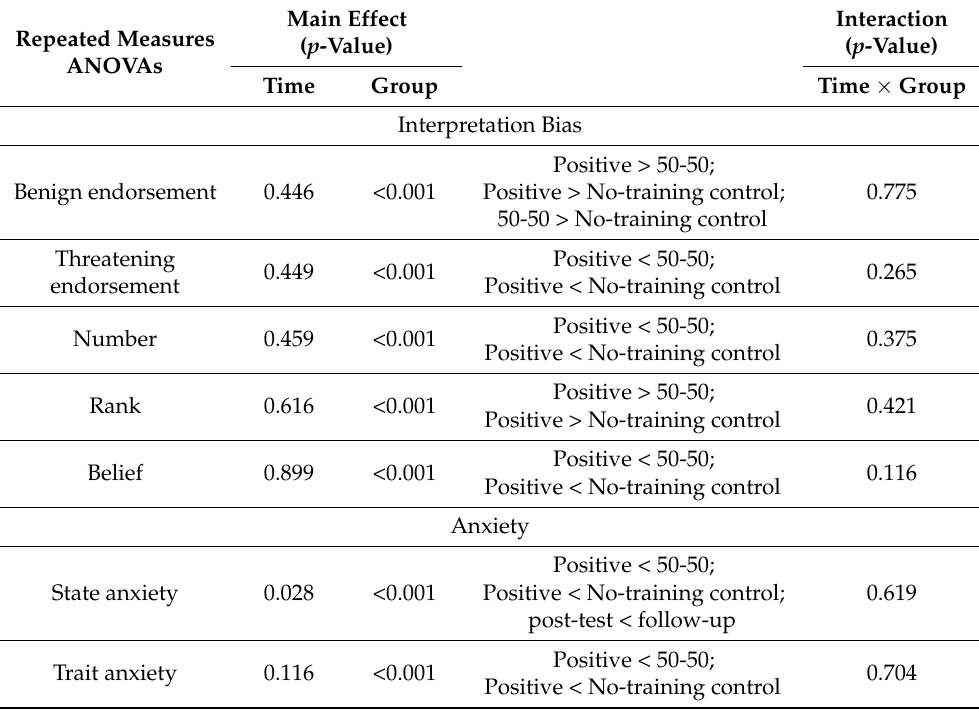
Table 2. The results of follow-up assessment (repeated measures